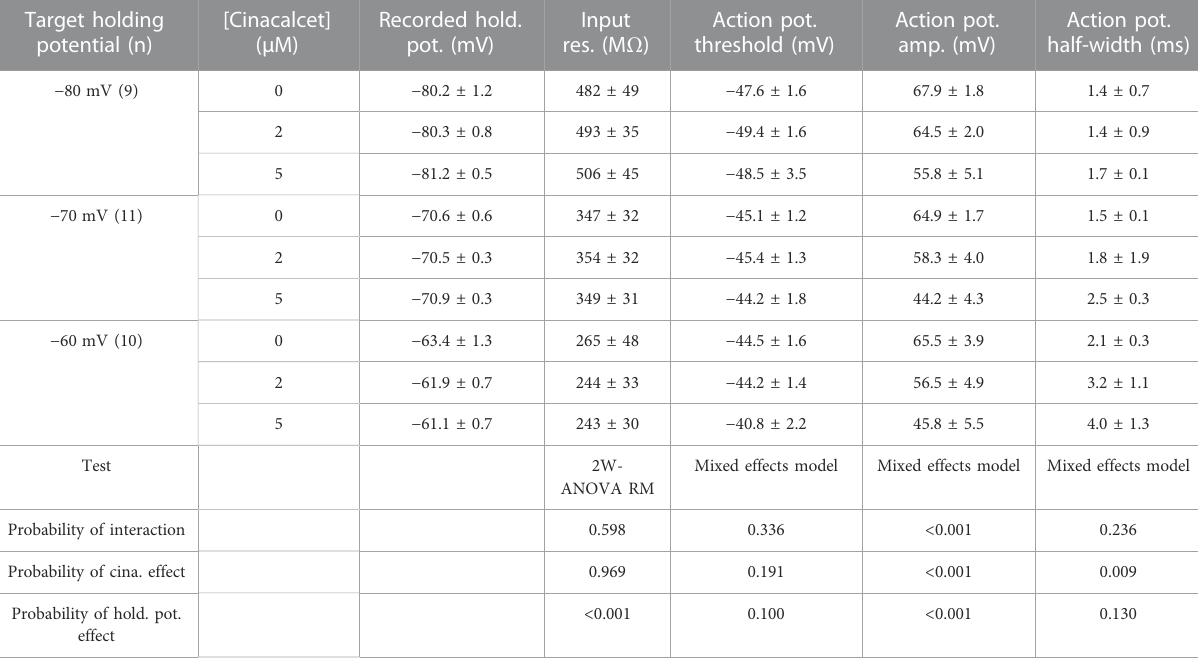
TABLE 3 Action potential characteristics. Target holding potential